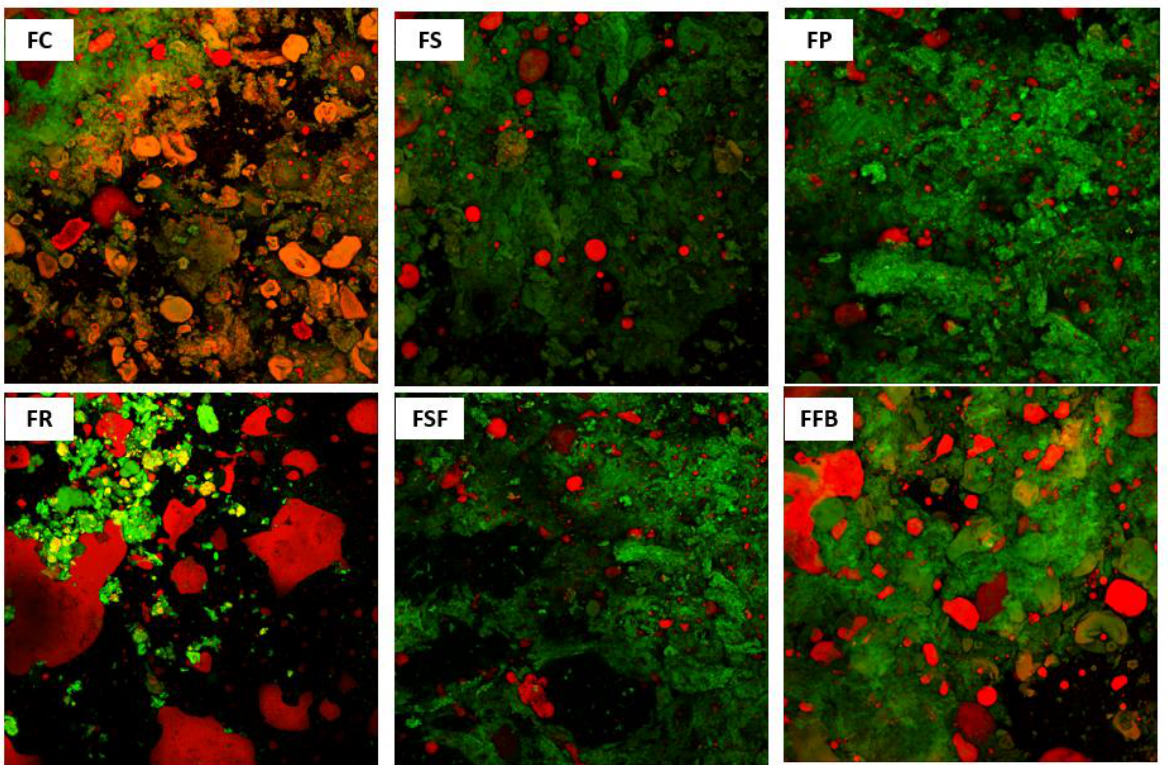
Figure 5. Confocal scanning laser microscopy images (magnification 20×, scale bar 100 µm) of hybrid meat emulsions elaborated with plant proteins as partial meat substitutes. FC: control; FS: soy; FP: pea; FR: rice; FSF: sunflower; FFB: fava bean.